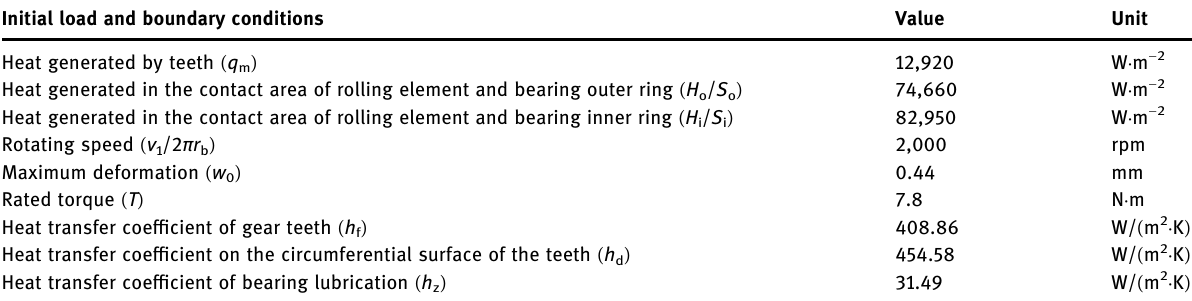
Table 1: Initial load and boundary conditions Initial load and boundary conditions